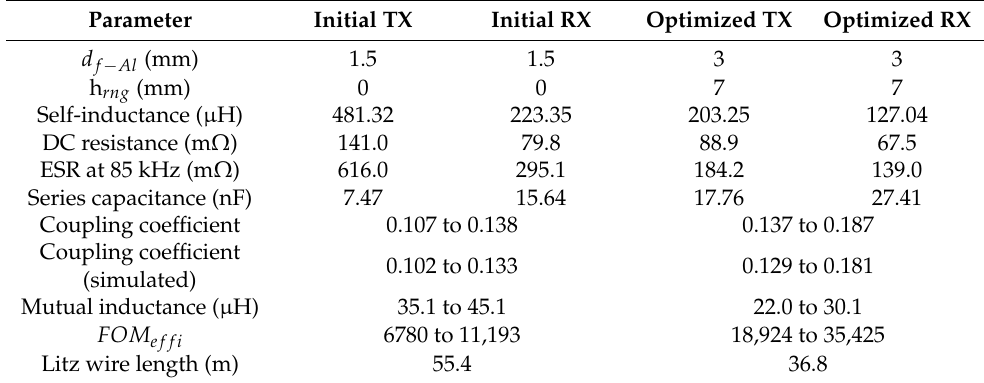
Figure 8. Geometric parameters of the initial and optimized coil assemblies (the aluminum plate is not shown). The coils are made of 600-strand Litz wires. Table 4. Simulated and measured parameters of the coil assemblies.